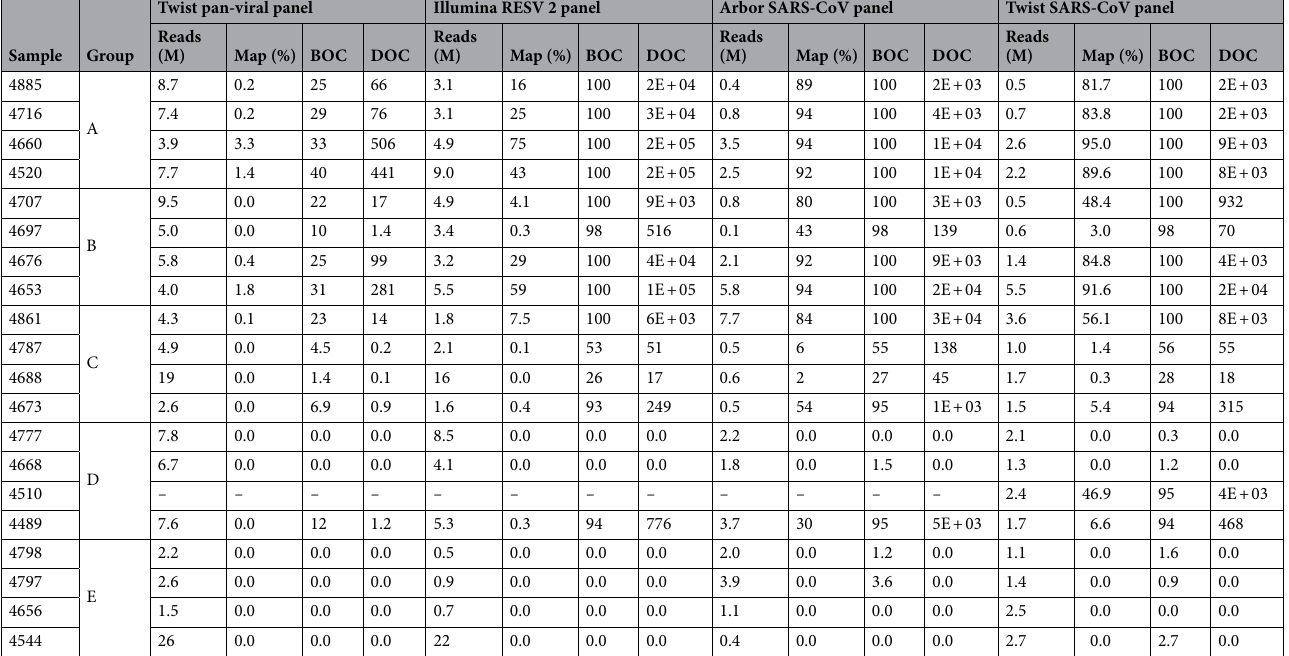
Table 3. Mapping results for all samples captured using the different SARS-CoV-2 panels. All data was mapped to the Wuhan SARS-CoV-2 sequence (accession MN908947.3). The DOC column indicates the depth of coverage (or mean sequencing depth). The BOC column indicates the breadth of coverage (percentage of genome covered by at least one read) 14